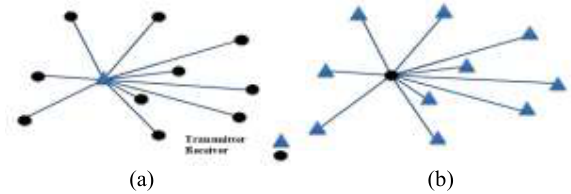
Figure 3 General configuration of a VLF/LF network. (a) Multi-receivers with a transmitter (b) multi-transmitters with a